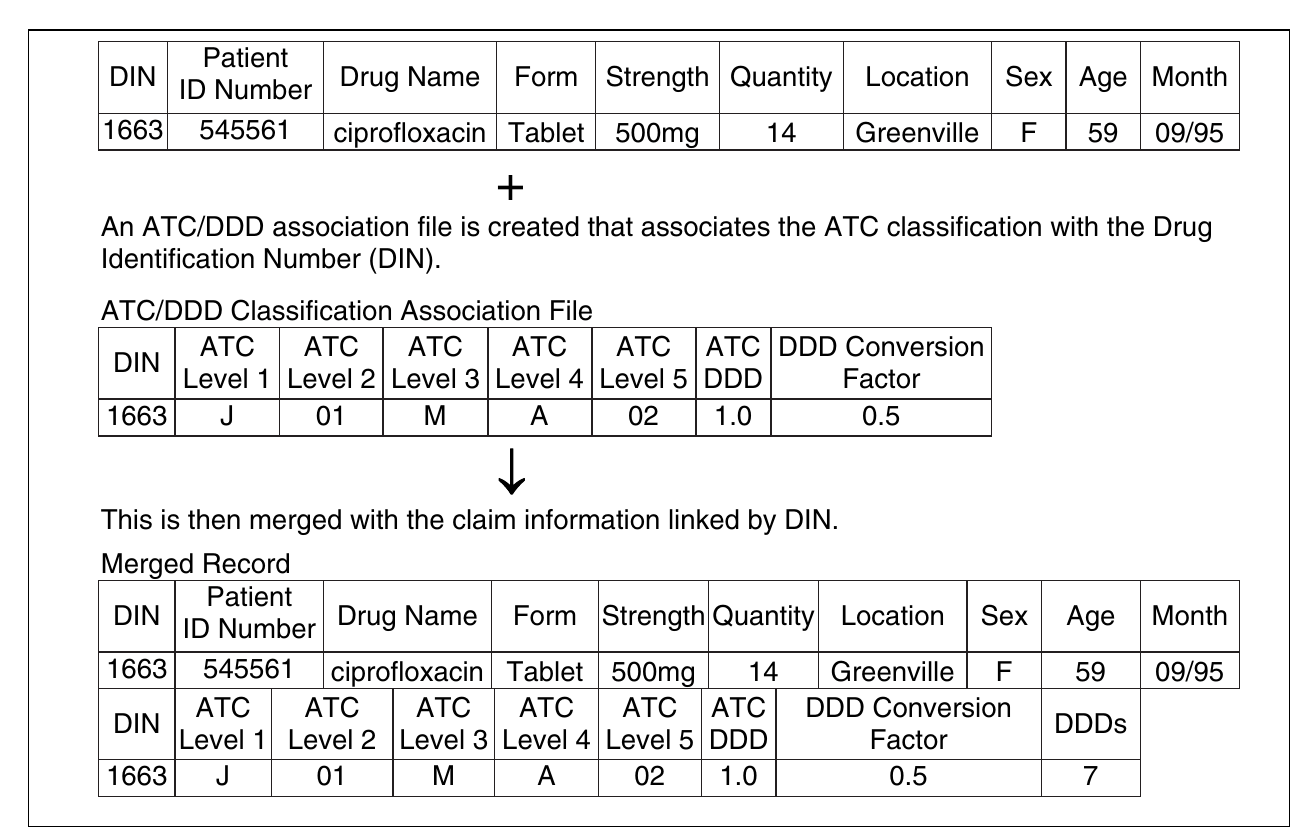
Figure 1) Process of merging typical outpatient pharmacy dispensing data with Anatomical Therapeutic Chemical/Defined Daily Dose